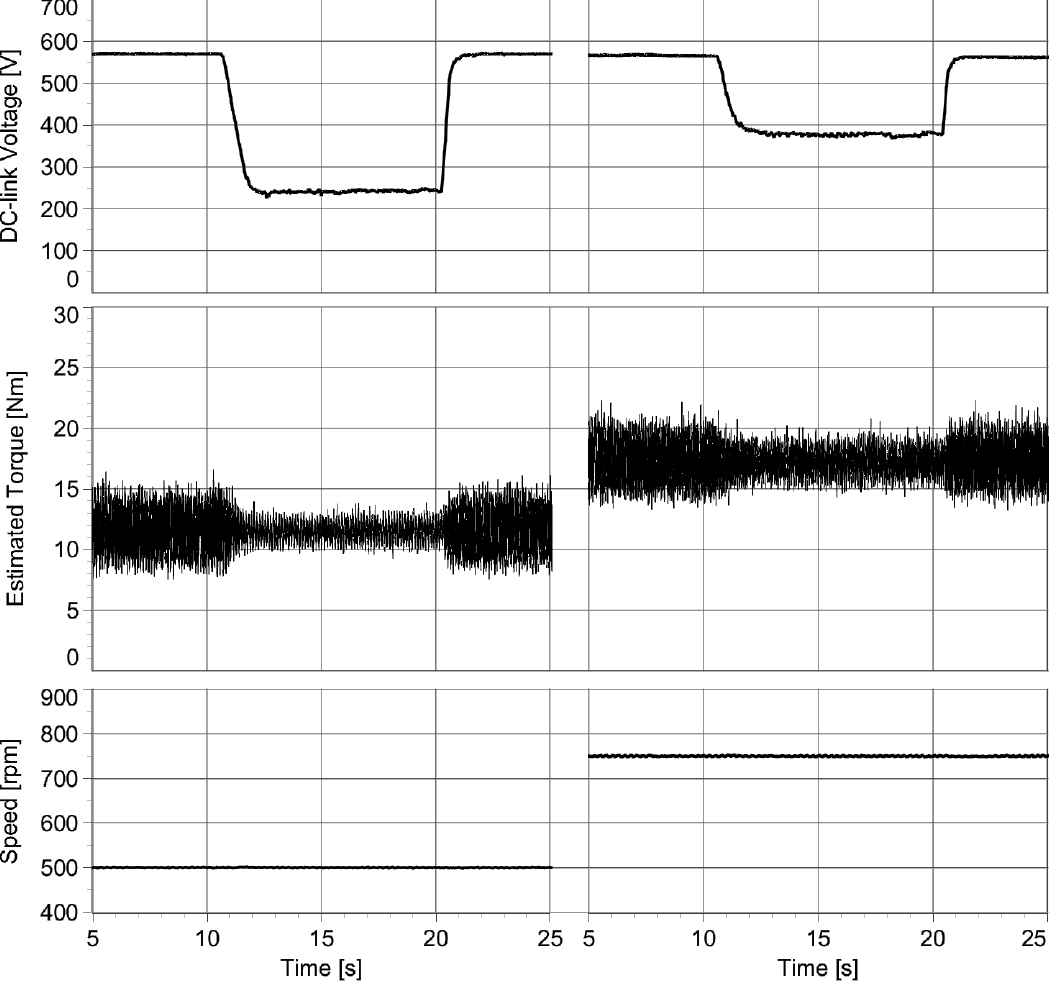
Figure 4. PTC operating at full and optimized DC-link voltage. Reference speed: 500 min − 1 (left) and 750 min − 1 (right); reference flux: 1 Wb; load torque: 12 Nm (left) and 17 Nm (right).